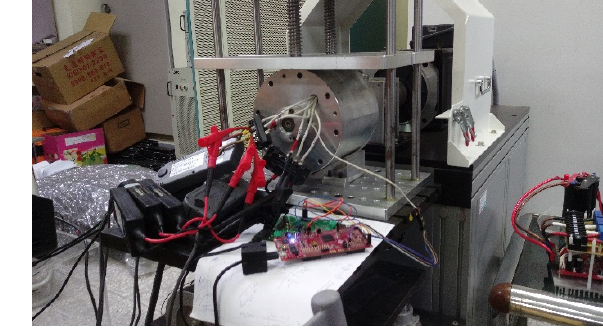
Figure 12. Experimental setup for evaluation of developed FI-PMa-SynRM prototype.